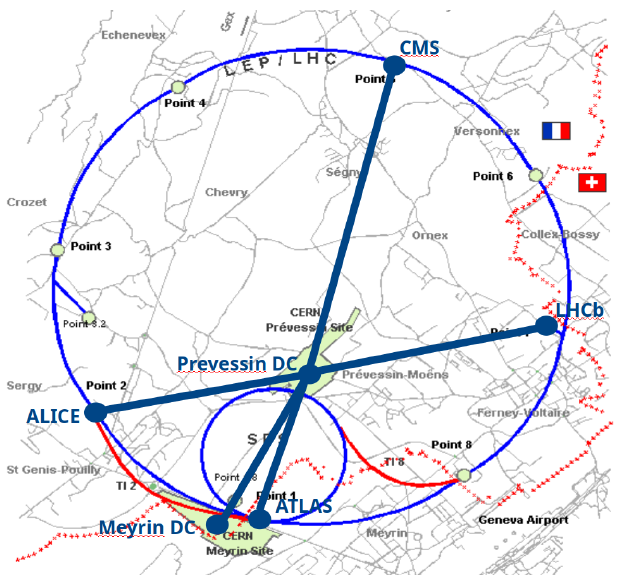
Figure 1. A proposal for a shared HLT